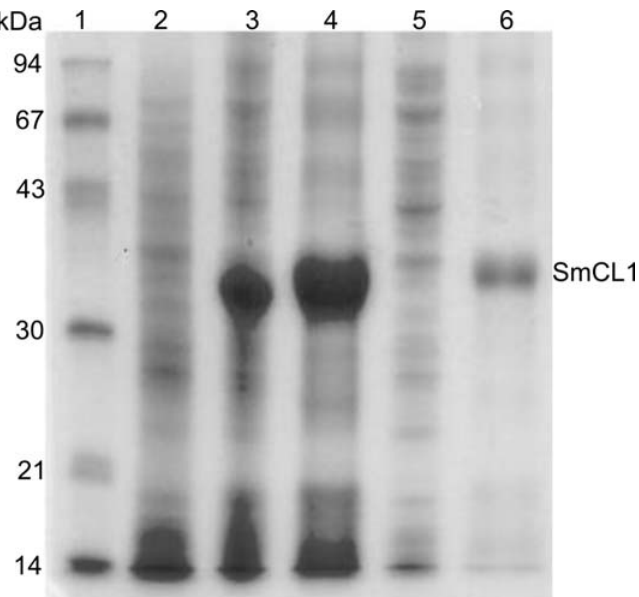
Figure 1. Analysis of the recombinant SmCL1expressed from NaCl-induced E. coli BL21-SI by SDS-12% PAGE. Bands were visualized by Coomassie staining. Lane 1: molecular mass protein markers; lane 2: non-induced culture; lane 3: induced culture; lane 4: inclusion body pellet after centrifugation (insoluble fraction); lane 5: supernatant after centrifugation (soluble fraction); lane 6: protein purified from insoluble fraction by Ni-charged resin